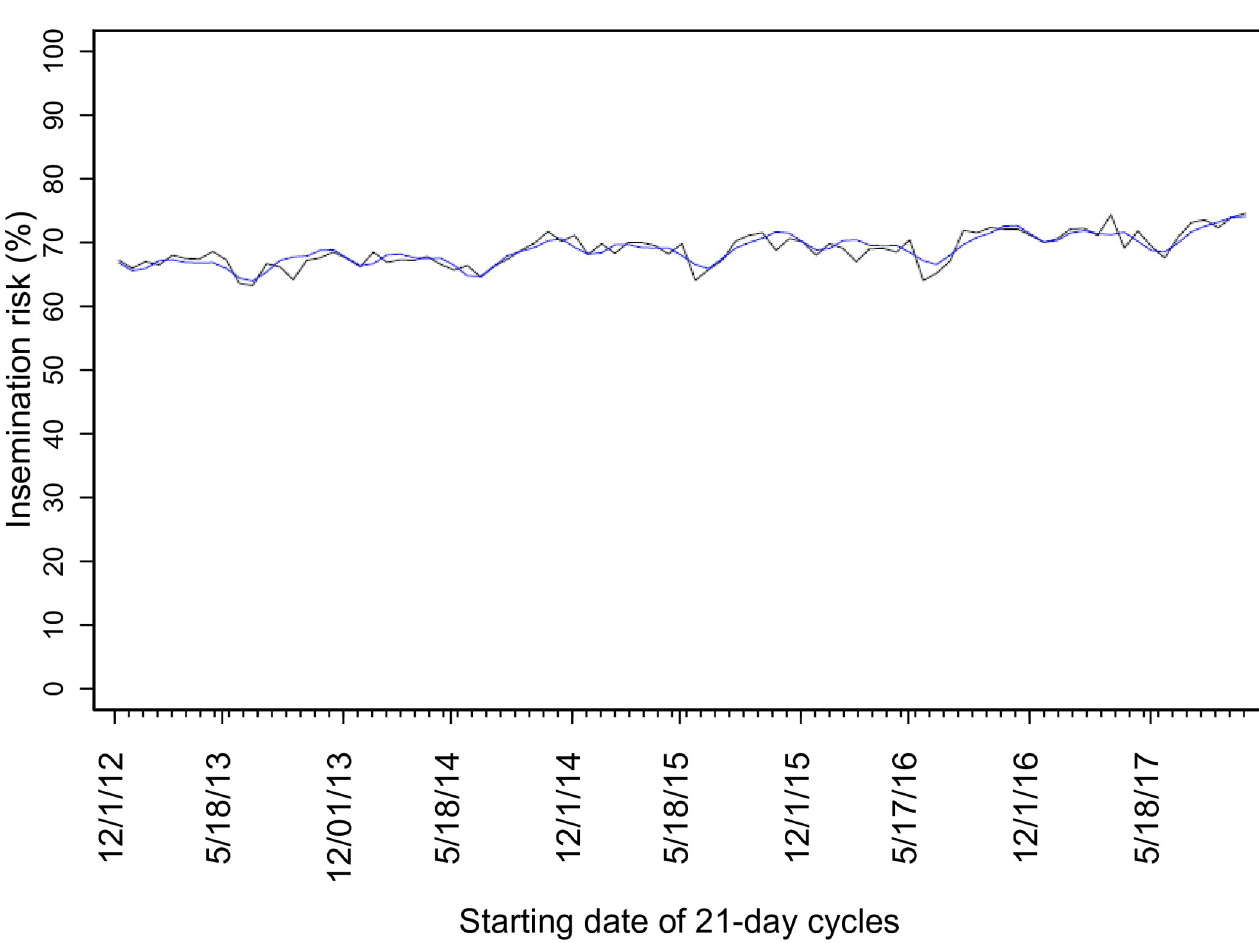
Fig 2. Time series model fit. Black and blue lines represent actual and estimated values for insemination risk, respectively.